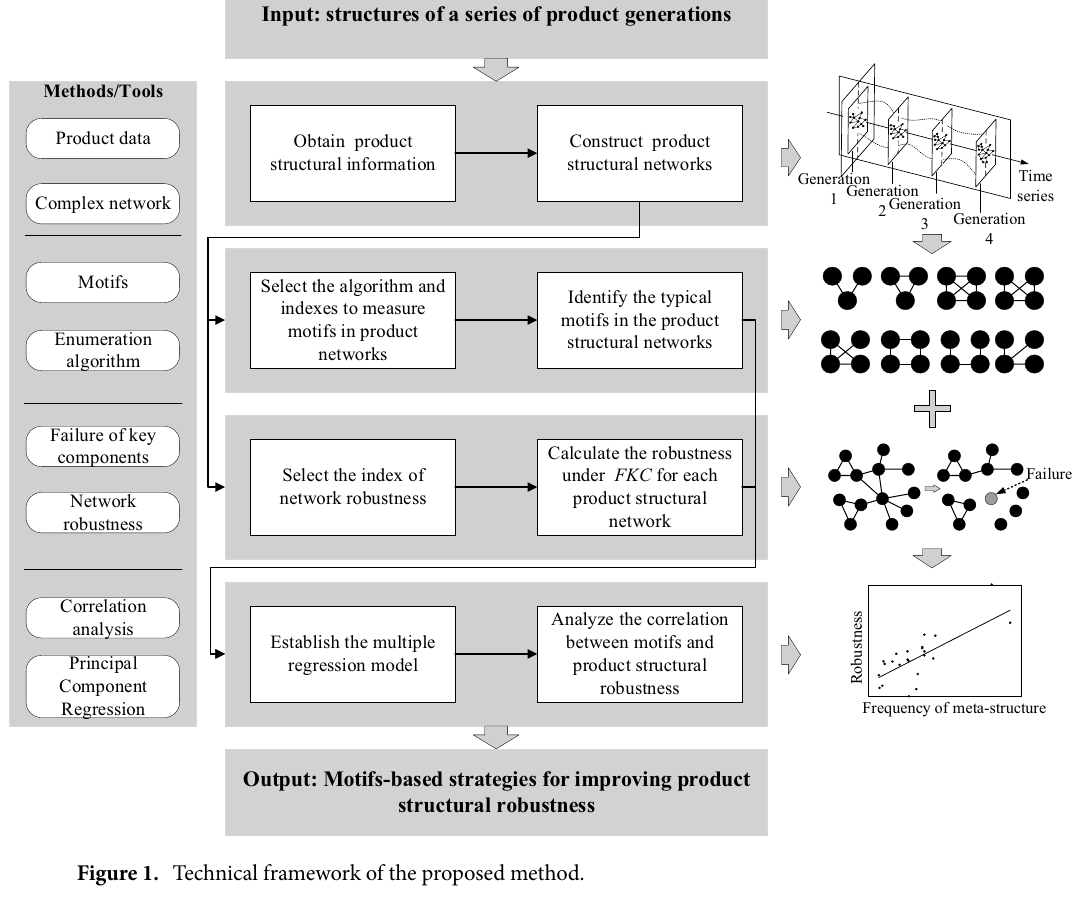
Figure 1. Technical framework of the proposed